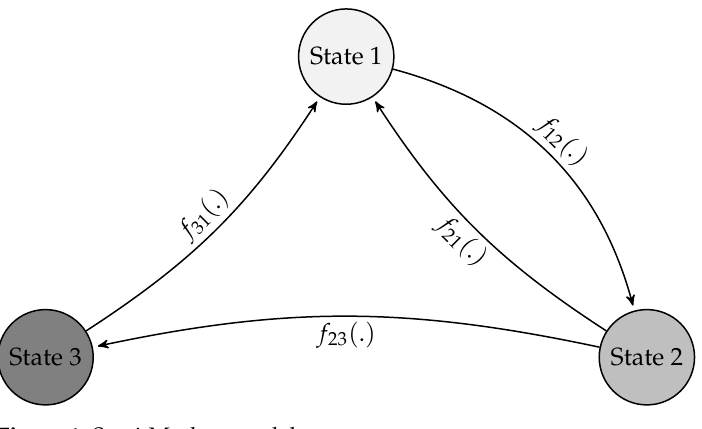
Figure 1. Semi-Markov